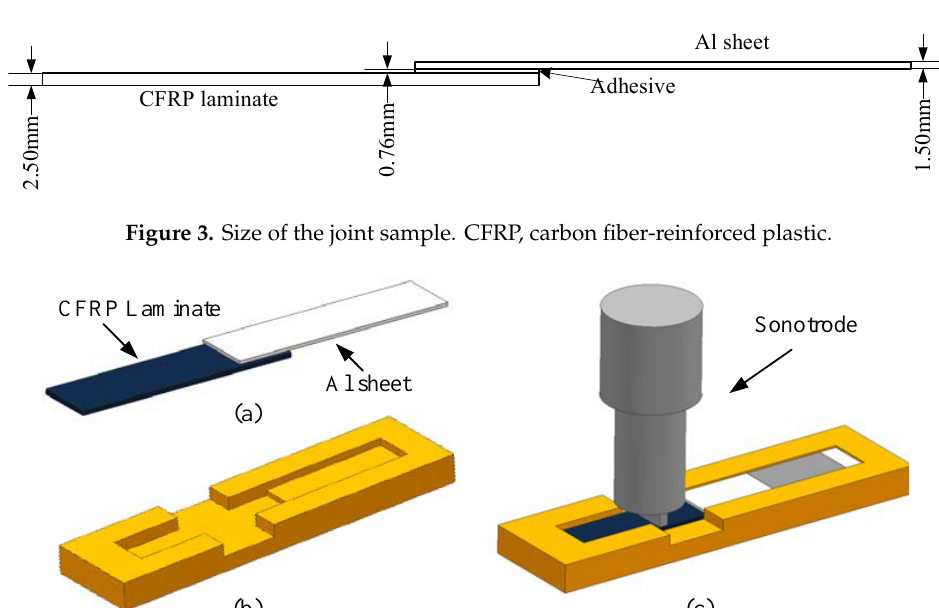
Figure 4. ( a ) The joint, ( b ) the fixture, and ( c ) the schematic diagram of clamping.